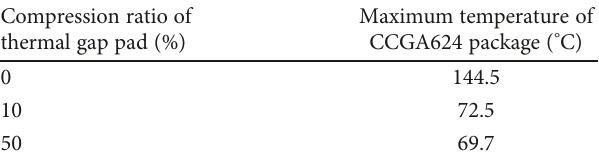
Table 2: Maximum temperatures of the CCGA624 package with various compression ratios of the thermal gap pad.